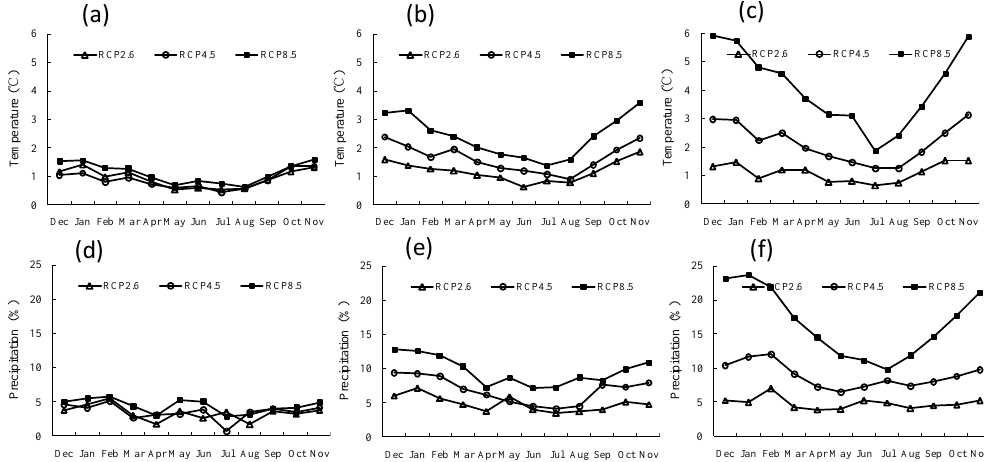
Figure 7. Changes in mean annual air temperature (a–c) and the relative change (RC) in precipitation (d–f) over Northern Hemisphere land for 2016–2035 (left), 2046–2065 (middle), and 2080–2099 (right) for three RCPs, relative to the 1986–2005 reference